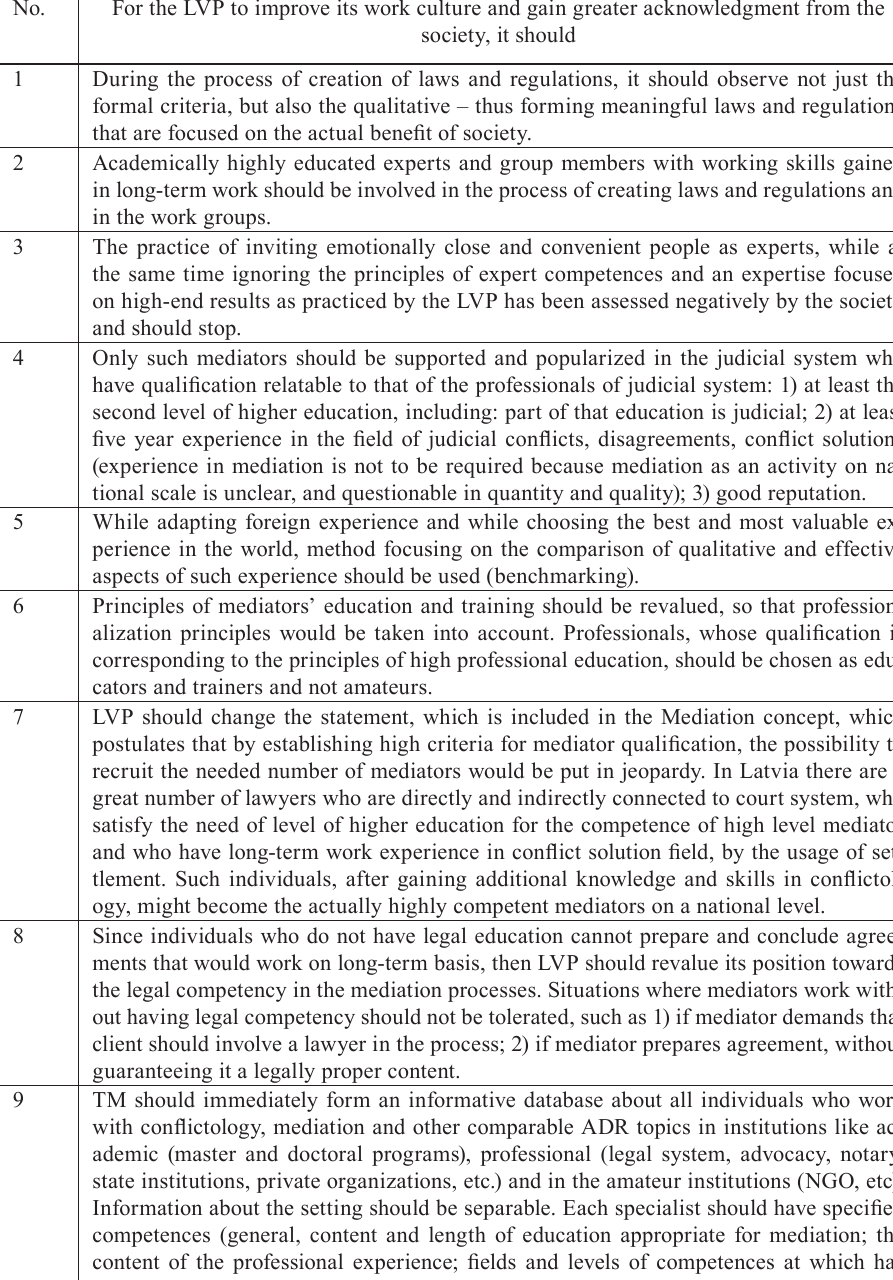
Table 2. Suggestions for the improvement of LVP work culture in relation to MIP No. For the LVP to improve its work culture and gain greater acknowledgment from the society, it